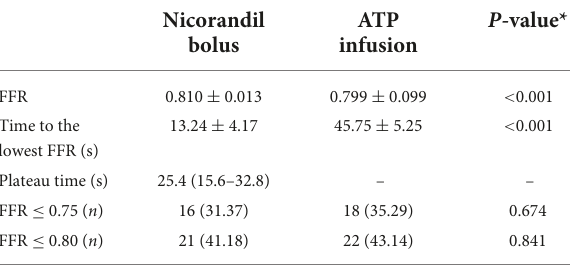
TABLE 3 Hyperemic efficacy and the number of functionally significant lesions according to two different hyperemia